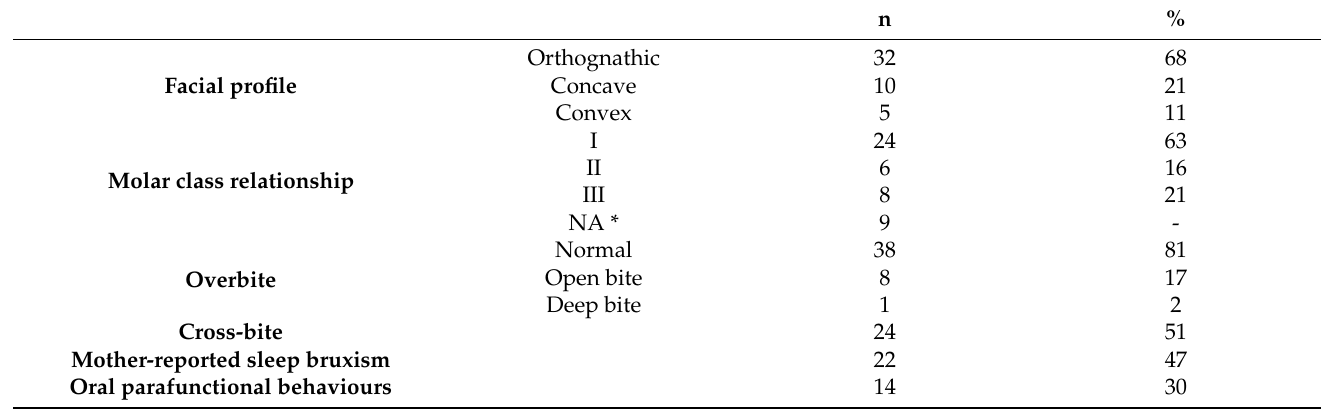
Table 3. Summary of the results from orthodontic assessment in Down syndrome